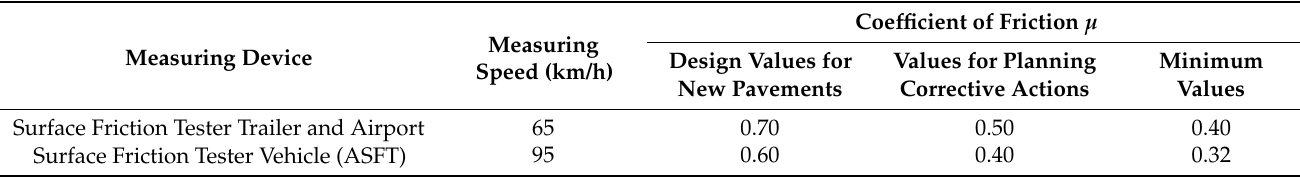
Table 2. Summary of measuring devices (ASFT) used to test the roughness of airfield pavements and the mean values of the required coefficients of